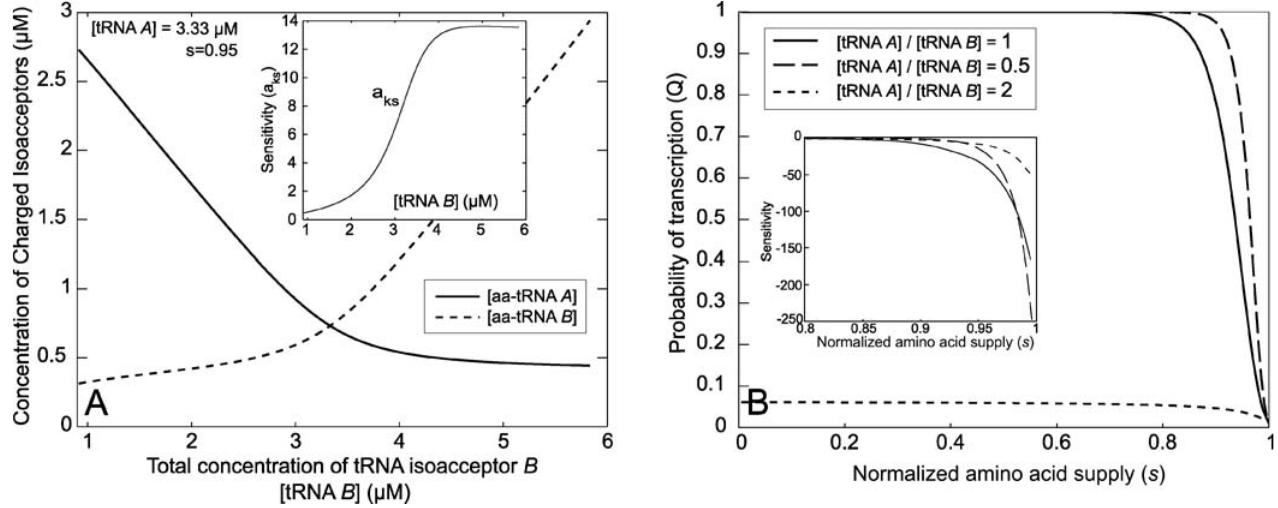
Figure 4. The Choice among Synonymous Codon (A) The predicted concentration of aminoacylated tRNA isoacceptor A (solid) and B (dashed) is plotted as a function of the total concentration of isoacceptor B for a fixed but limiting supply of the cognate amino acid ( s ¼ 0.95). The codon usage of a and b are both equal to 2.5%, and the total concentration of tRNA isoacceptor A is kept constant at 3.33 l M. Insert : The sensitivity in rate of reading a codons by the A isoacceptor in response to a change in amino acid supply is plotted over the same interval as the main figure. (B) The probability of read-through is plotted as a function of normalized amino acid supply rate. The attenuation control codon a is translated by tRNA isoacceptor A. The same amino acid is also encoded by another codon b, which is translated by tRNA isoacceptor B . The codon usage of a and b are both equal to 2.5%. The different curves correspond to different ratios between the total concentrations of isoacceptor A and B, as indicated in the figure. As m ¼ 10, n ¼ 50, and k max ¼ 20 s (cid:1) 1 , the situation where the concentrations are equal corresponds to the solid curve in Figure 3. Insert: The sensitivity a Qs for the three cases. More details about the calculations are given in the Supporting Information and reference [16]. DOI: